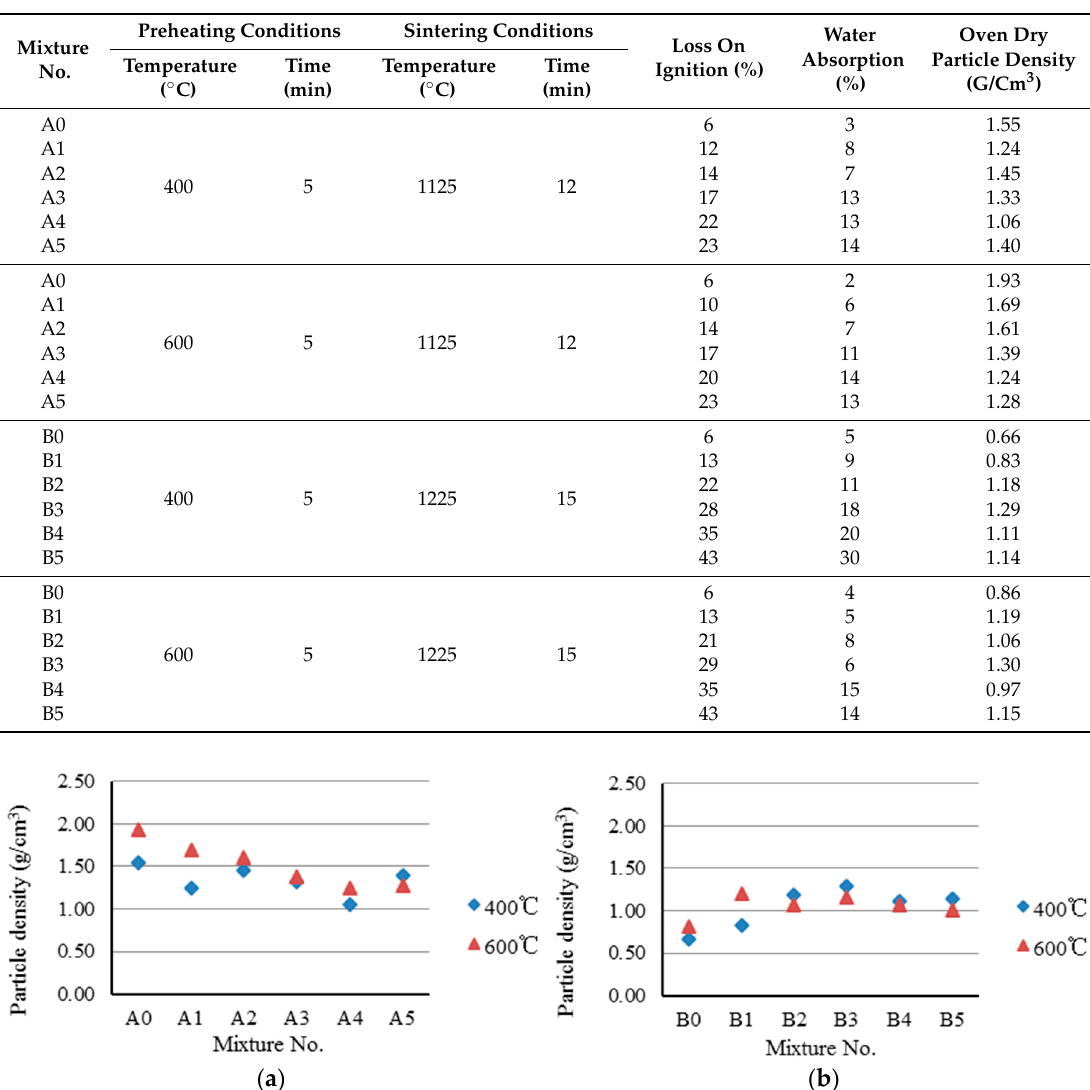
Table 4. Production results of paper sludge lightweight aggregates.